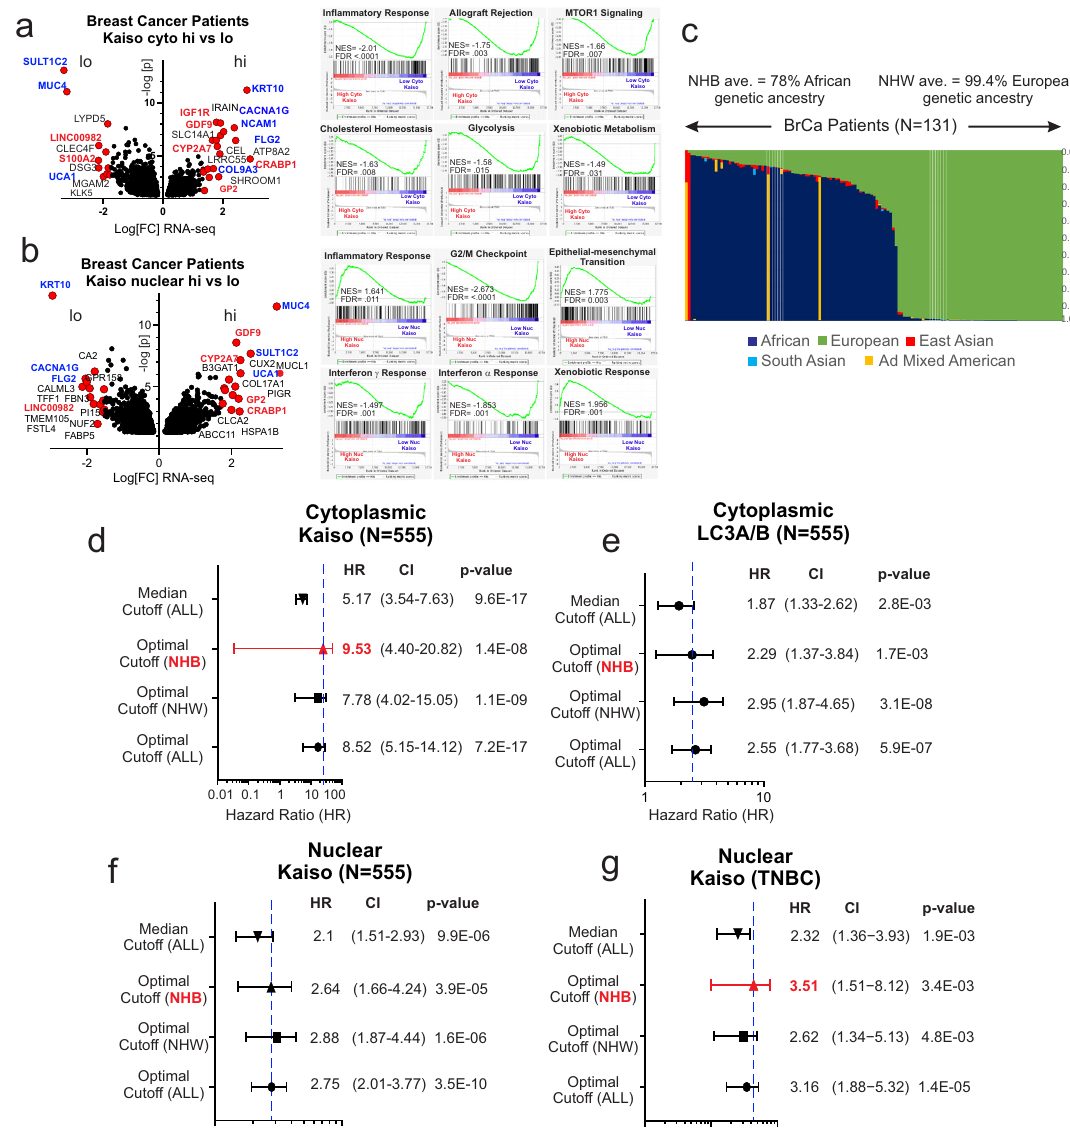
Fig. 6 Patients strati fi ed by nuclear and cytoplasmic Kaiso are variably enriched in cell stress and immune response pathways and differentially predict survival based on genetic ancestry. a Volcano plot of differential gene expression of patients strati fi ed by nuclear Kaiso. (Right) Gene set enrichment analysis of patients strati fi ed by cytoplasmic Kaiso (Supplementary Data 5 and 6). b Volcano plot of differential gene expression of patients strati fi ed by cytoplasmic Kaiso (right) Gene set enrichment analysis of patients strati fi ed by nuclear Kaiso. c Population-speci fi c composition of a representative portion ( N = 131) of the breast cancer cohort, by genetic ancestry-based ancestry informative markers extracted from the RNA-seq data. Indicated colors re fl ect the percent admixture of each genetic population. d Forest plot analysis of overall survival hazard-based optimized cut-off for cytoplasmic Kaiso for the total population, NHW patients, NHB patients, and median cut-off for the total population. e Forest plot analysis of overall survival hazard-based optimized cut-off for LC3A/B in the total population, NHW patients, NHB patients, and the median cut-off for the total population. f Forest plot analysis of overall survival hazard based on optimized cut-off for nuclear Kaiso in the total population, NHW patients, NHB patients, and the median cut-off for the total population. g Forest plot analysis of overall survival hazard based on optimized cut-off for nuclear Kaiso in TNBC patients using optimized cut-off for NHW patients, NHB patients, and the median cut-off for the total TNBC microarray. Replicate tissue microarrays were constructed using 1mm cores per Genomics Institute (BGI) (Beijing, China) where RNA was extracted and previously described methods 73,74 , with a representation inclusive of 555 patients. sequenced (60M paired-end reads per sample) as previously described 75,76 . Detailed methods for IHC, scoring, and the assignment of clinical variables are Detailed methods are provided in the data supplement. provided in the Supplementary Methods. Immuno fl uorescence . Cells were grown on 22-mm-glass coverslips in 6-well Patient tumor RNA-seq analysis . RNA-seq analysis was performed on RNA plates to ~80% con fl uency before exposure to appropriate drugs or vehicular extracted from FFPE tissue blocks (Total N = 126; EA N = 61; AA N = 65, controls. After washing with PBS, cells were fi xed with 4% formaldehyde in PBS at Other = 1) 6 . Following a review of H&E stained slides, areas for tumors with >80% room temperature (RT) for 10min. Cells were permeabilized with 0.1% Triton X- 100 for 10min, then incubated with blocking medium (PBS, 0.1% Tween-20, 10% nuclei were circled, and 2.5 × 2 – 3 mm tissue cores were extracted from the cor- normal goat serum) for 30 min in a humidi fi ed chamber at RT. Blocked samples responding regions of FFPE tissue blocks. Cores were shipped to the Beijing